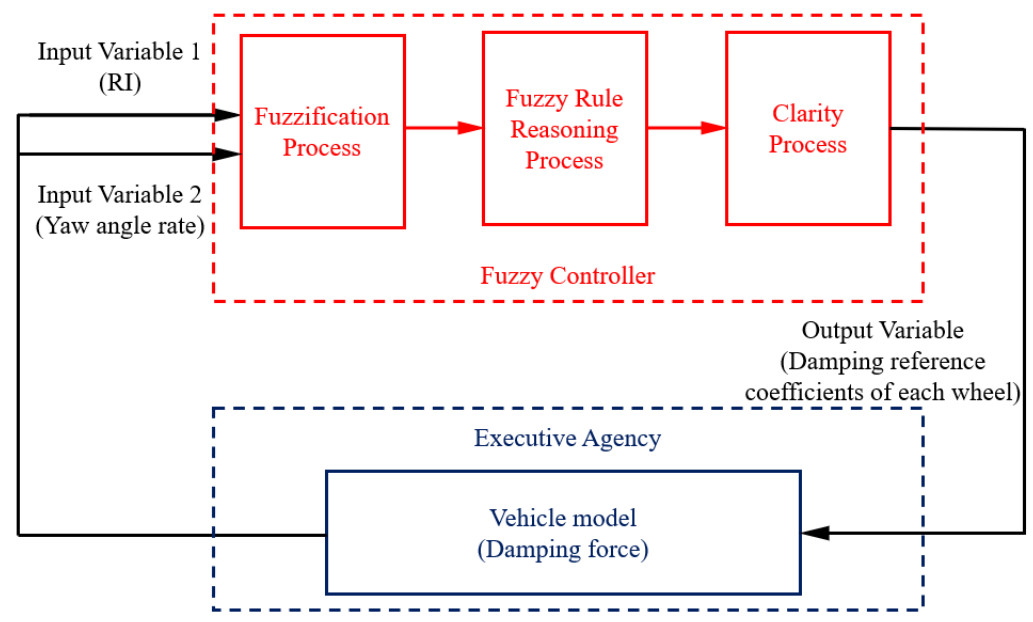
Figure 7. Multi-objective fuzzy continuous damping control structure.